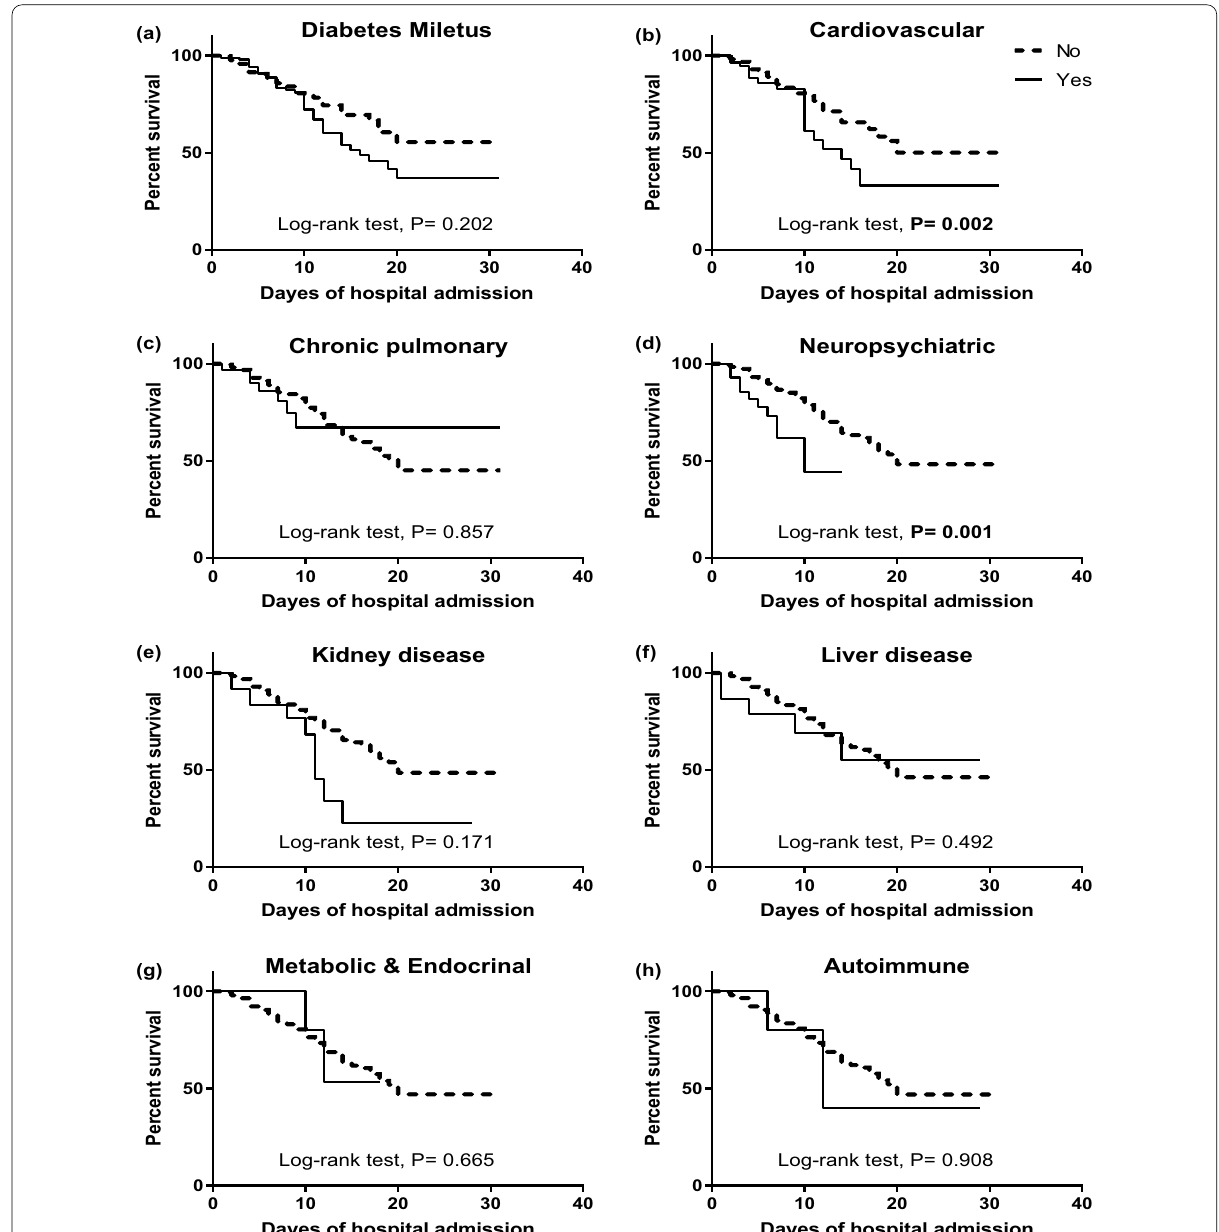
Fig. 3 Kaplan–Meier survival curve of COVID‑19 cases based on different associated comorbidities ( n